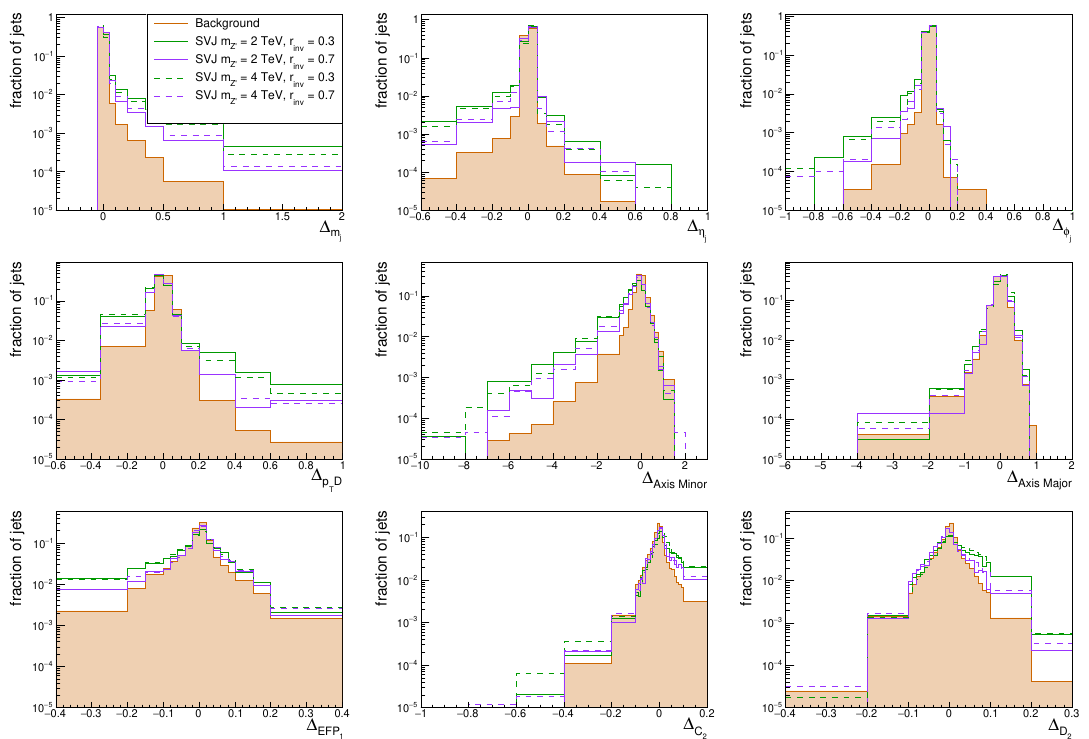
Figure 3. Distributions of difference between input and reconstructed jet features for QCD and a few example SVJ signals.